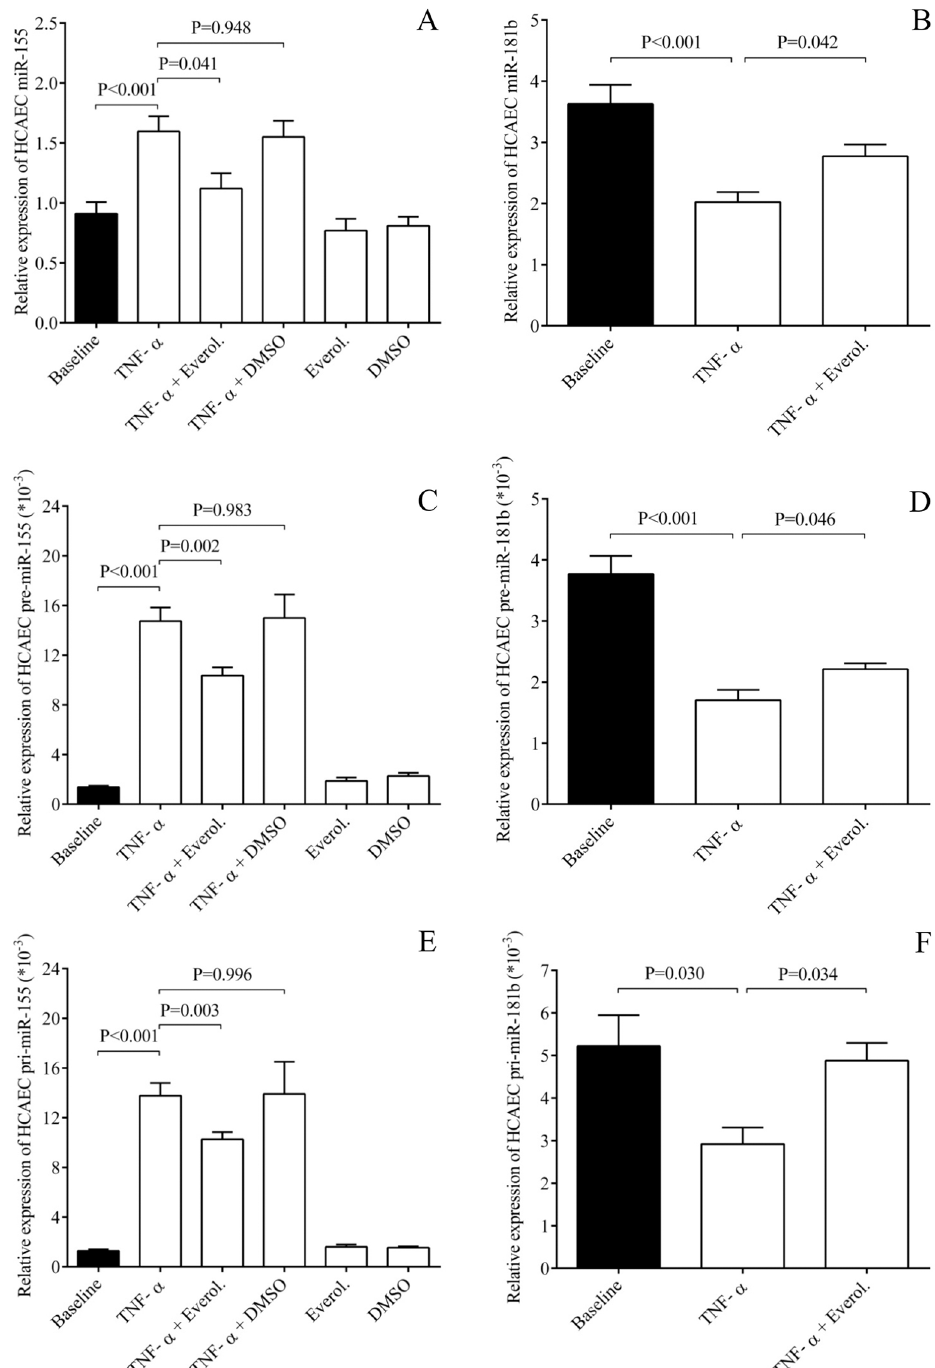
Fig 5. Quantification of TNF- α induced miR-155 and miR-181b levels with the analysis of their precursors in the presence of everolimus upon EC inflammation in vitro . HCAECs were treated by recombinant TNF- α for 1–4 hours to analyze miR-181b expression along with the inflammation-specific miR-155. First, miR-155 was elevated by TNF- α compared to untreated sample, however, everolimus caused significantly decreased miR-155 levels (A), while miR- 181b was downregulated by the inflammatory stimulus and the treatment with everolimus restored their expression in both EC cultures (B). Levels of pre- and pri-miRNA were altered in the same manner as seen in mature miR-155 (C, E) and miR-181b (D, F), respectively. Mean ± SEM, n = 4-8/group.